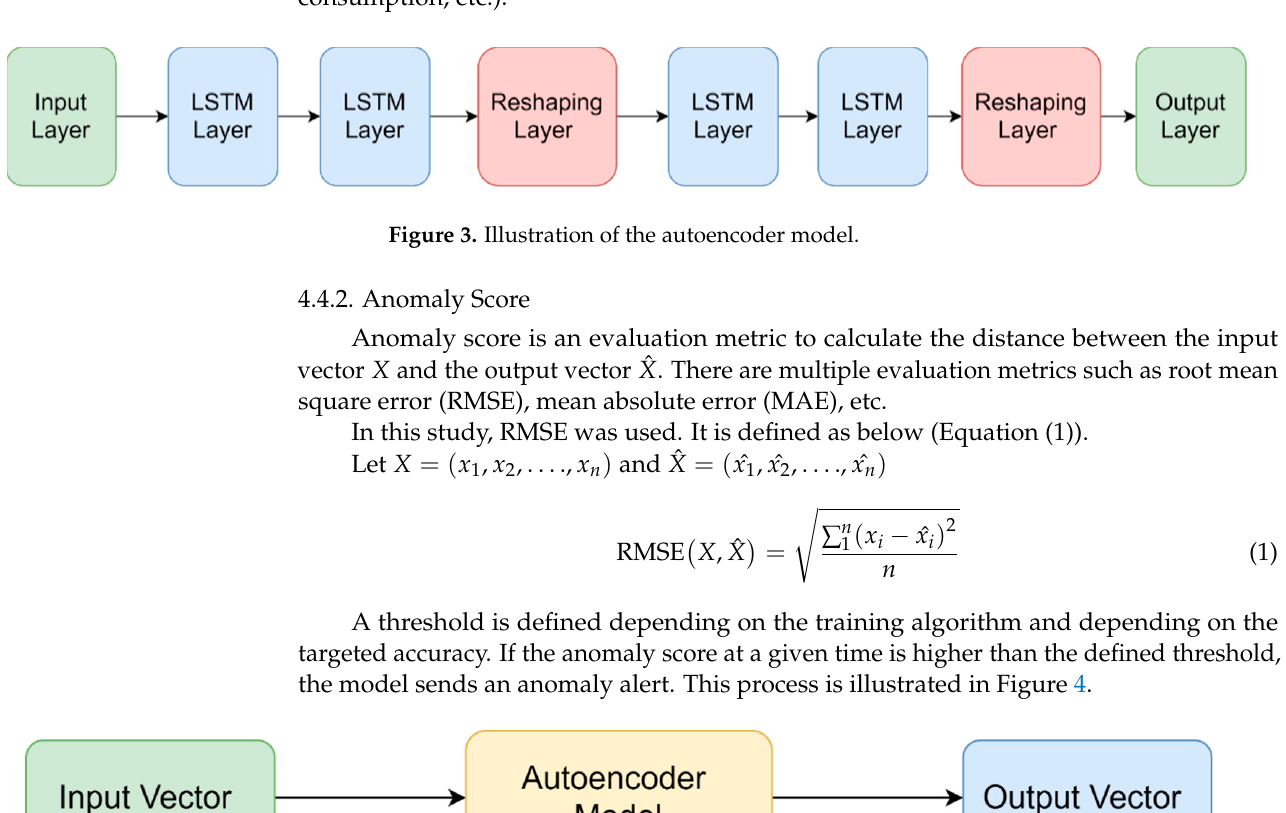
Figure 3. Illustration of the autoencoder model.